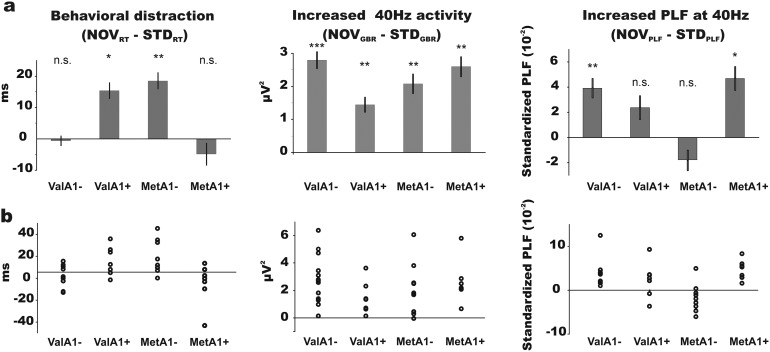
RT, amplitude and PLF of 40 Hz oscillatory activity for novel relative to standard trials.(a) Left panel shows the mean RT for novel compared to standard trials; notice that only the ValA1+ and MetA1- groups had larger RT for novel as compared to standard trials. Middle panel shows the increase in amplitude of neural oscillations at 40 Hz locked to novel sounds compared to that locked to standard sounds at Cz. Notice that amplitudes were larger after novel compared to standard sounds in all four groups. Right panel shows the increase of the PLF of neural oscillations at 40 Hz locked to novels sounds relative to that locked to standard sounds at Cz. Notice that PLF was larger after novel compared to standard trials in only the ValA1- and MetA1+ groups. (b) Scatter plots of individual values for RT (left panel), amplitude of the evoked 40 Hz oscillatory activity (middle panel), and PLF of the 40 Hz oscillatory activity (right panel). (*, p<0.05; **, p<0.01; ***, p<0.001; n.s., p>0.05).